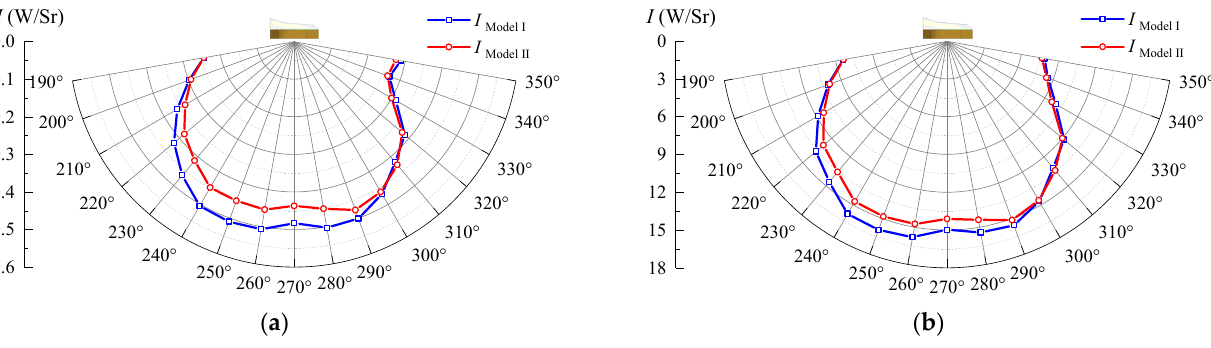
Figure 25. Infrared radiation intensity of rear fuselage surface. ( a ) 3–5 µm band; and ( b ) 8–14 µm band.